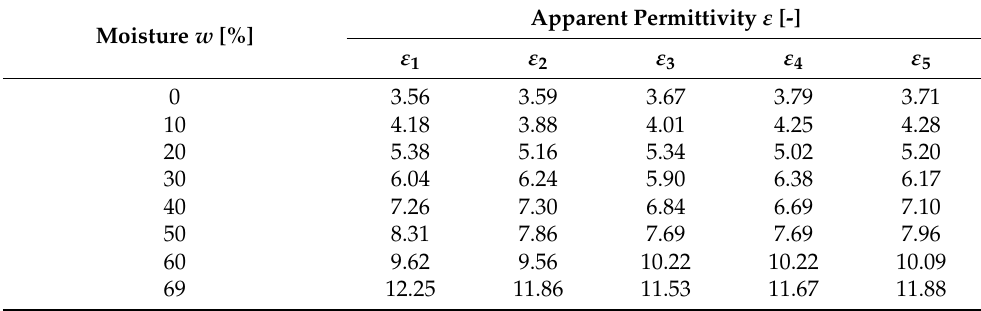
Table 3. Results of the apparent permittivity ε measurements with the S2 surface sensor for different values of moisture w ; 400 c.c. sample.